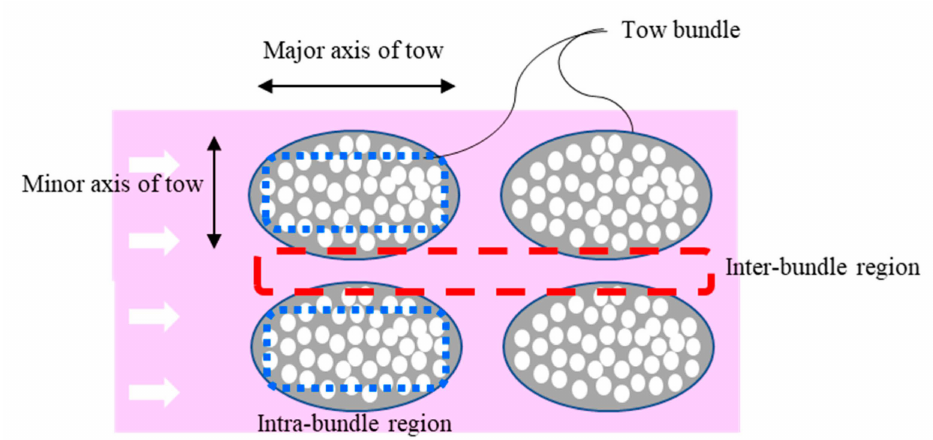
Figure 2. Two representative indices: tow thickness (minor axis)/the major axis, and tow bundle